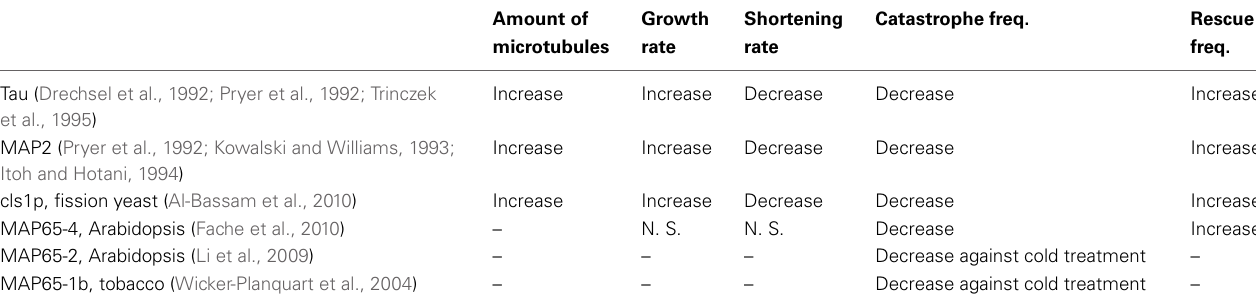
Table 2 | Effects of microtubule stabilizers on microtubule